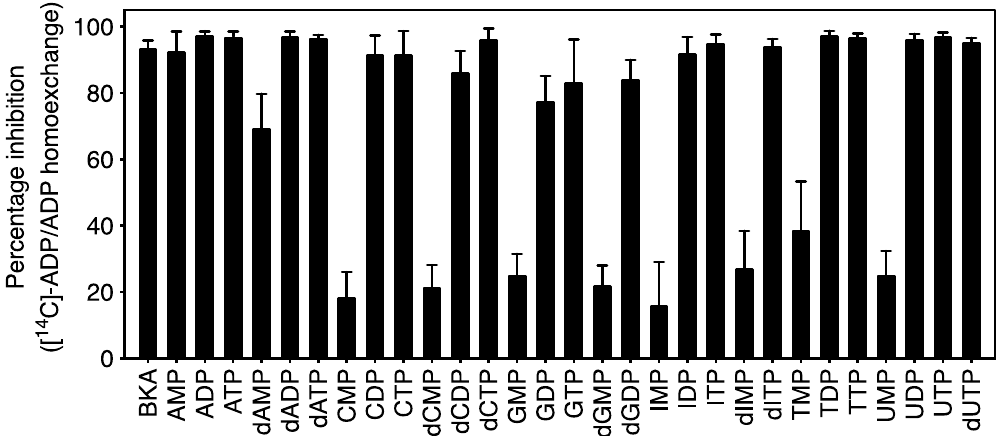
Figure 6. Nucleotide competition experiments of ADP/ADP homo-exchange by CpAAC. Percentage of inhibition of [ 14 C]-ADP/ADP homo-exchange in the presence of 2.5 mM of non-radiolabeled nucleotides (1667-fold excess). Transport was initiated by the addition of 1.5 μ M [ 14 C]-ADP to fused vesicles, preloaded with 5 mM non-radiolabeled ADP. The data are represented by the mean and standard deviation of two biological repeats, each performed in quadruplicate.